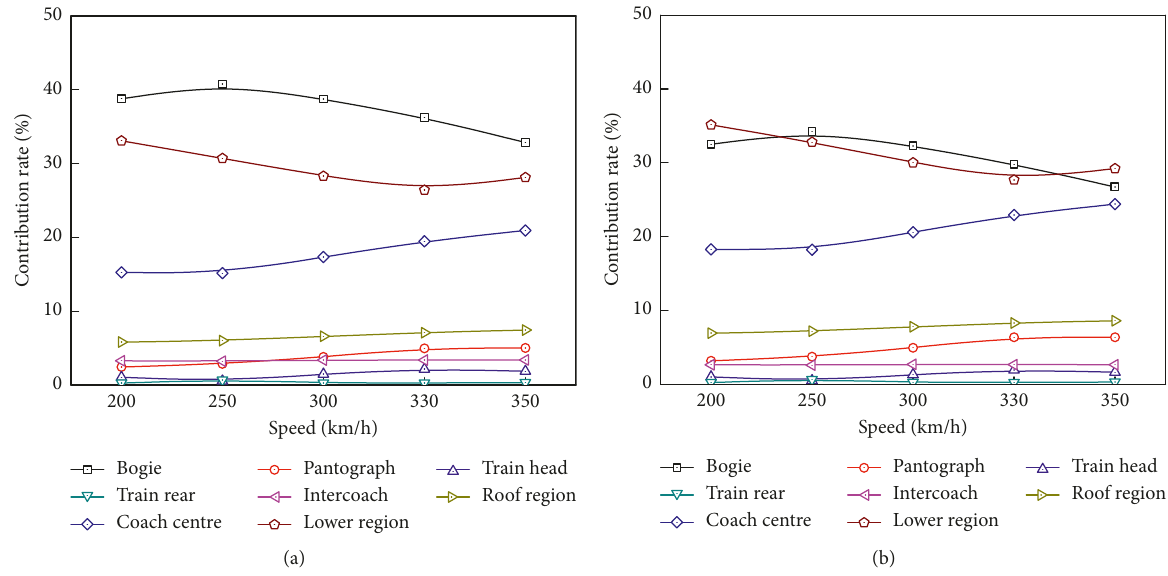
Figure 17: Contribution rates of the exterior sound sources to the pass-by noise at different speeds. (a) 7.5m from the centreline of the track; (b) 25 m from the centreline of the track.